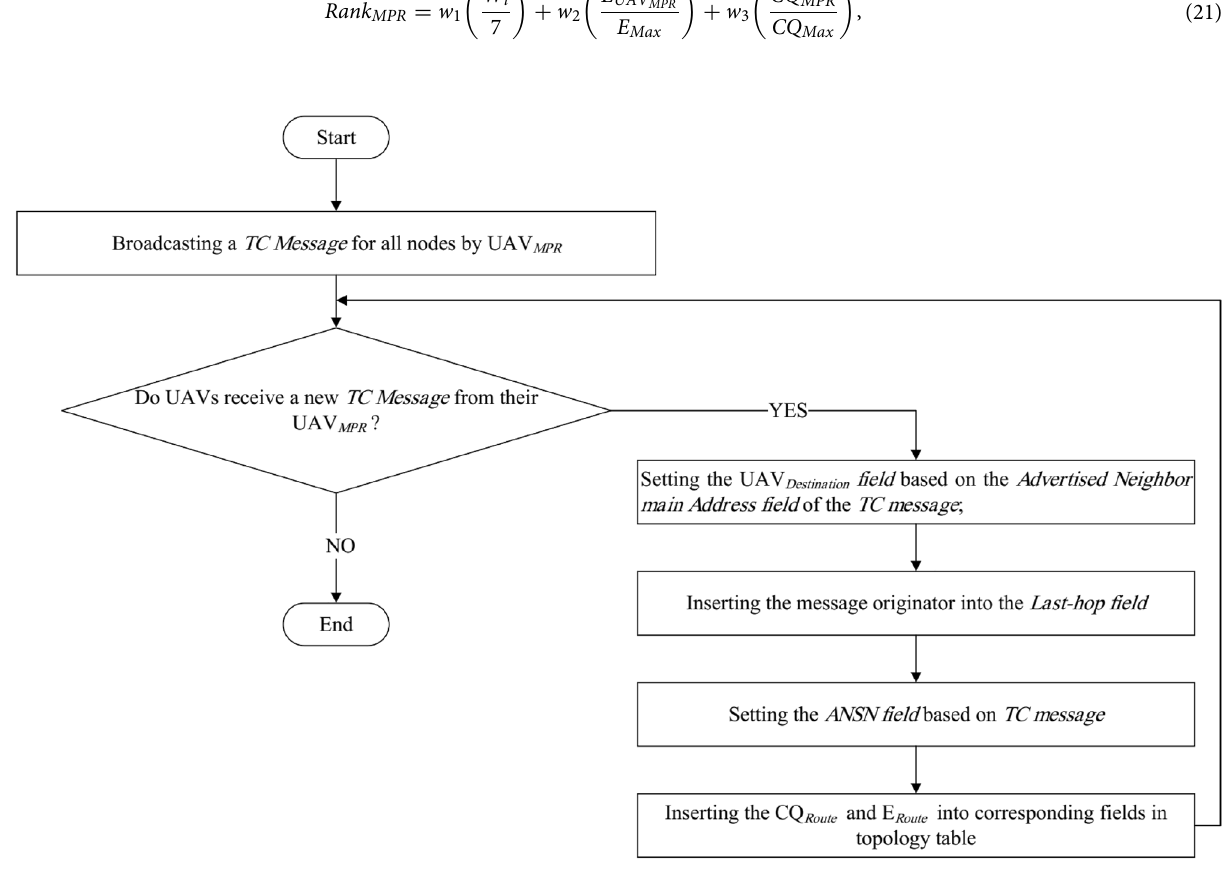
Figure 6. Flowchart of the network topology discovery.